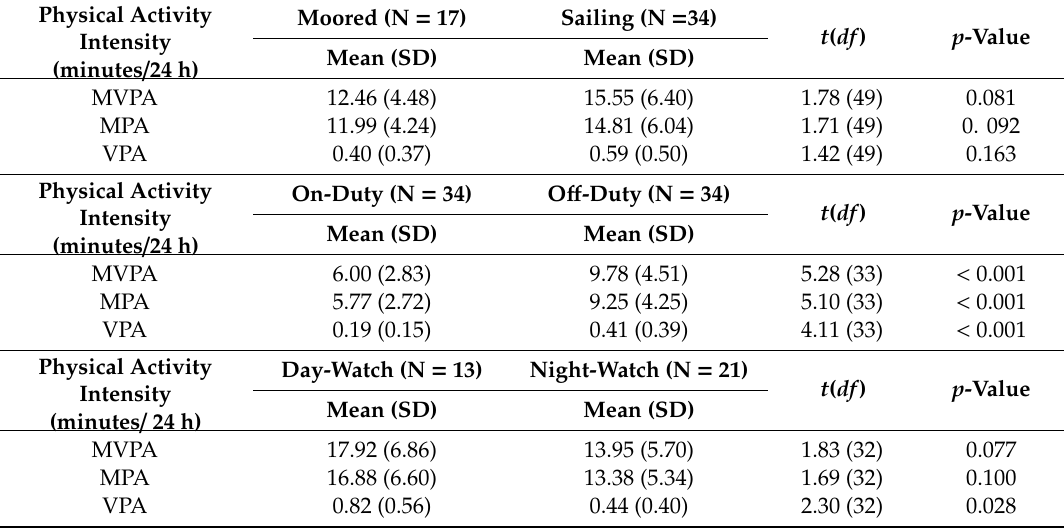
Table 2. The comparison of time spent on various physical activity levels in di ff erent settings (N =